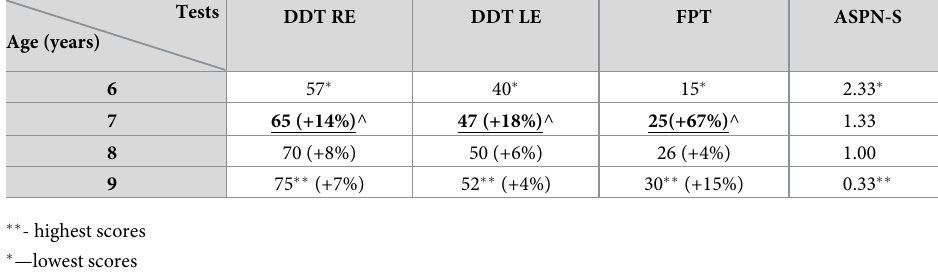
Table 15. Comparison of median APD results in age groups in group”S”.